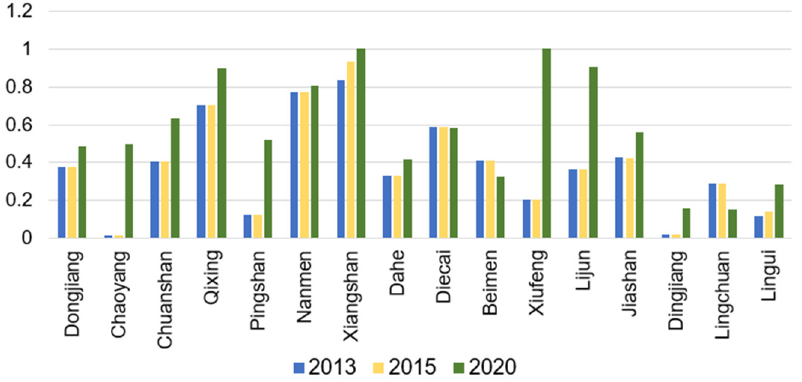
Figure 4. Number and percentage of the population with access to public transport stops from 2013 to 2020 in Guilin.